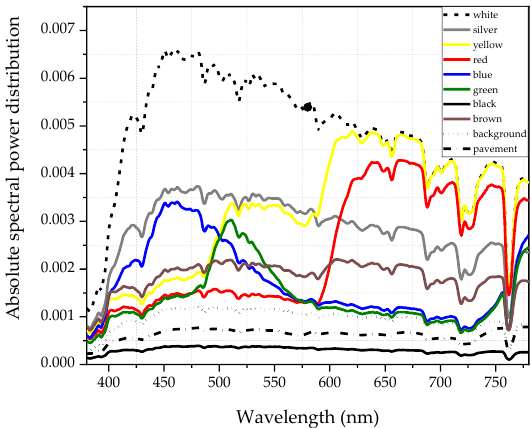
Figure 5. Targets used in experiment with different colors.